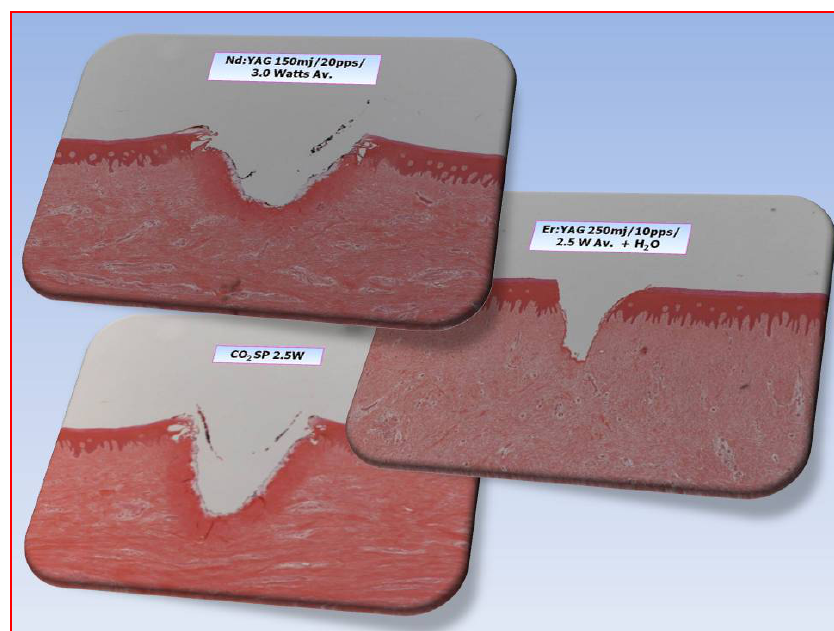
Figure 6. Comparative light micrographs of laser interaction with porcine oral soft tissue. Top: Nd:YAG 1064 nm (an example of the shorter wavelengths employed), causes a wider, crater-shaped area of ablation, with some areas of thermal conduction. Right: Longer wavelengths such as FRP Er:YAG 2940 nm create a sharper “V” shaped incision, whereas Bottom: CO 2 10,600 nm, being a gated CW emission, results in some features of the other two—surface configuration ascribable to absorption in water, but some thermal spread arising from a comparative lack of thermal relaxation.